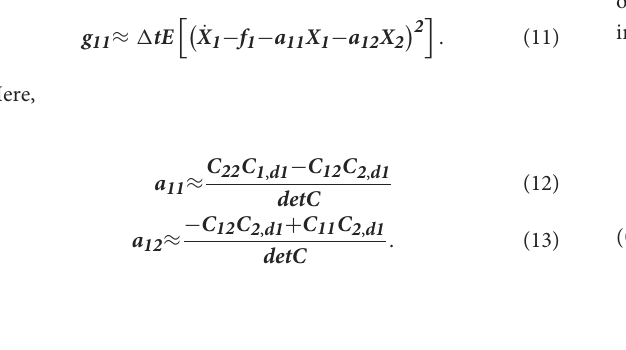
where σ 2 can be replaced by the covariance of sample C 11 , 1 and g 11 can be obtained using the MLE in Equation (8)